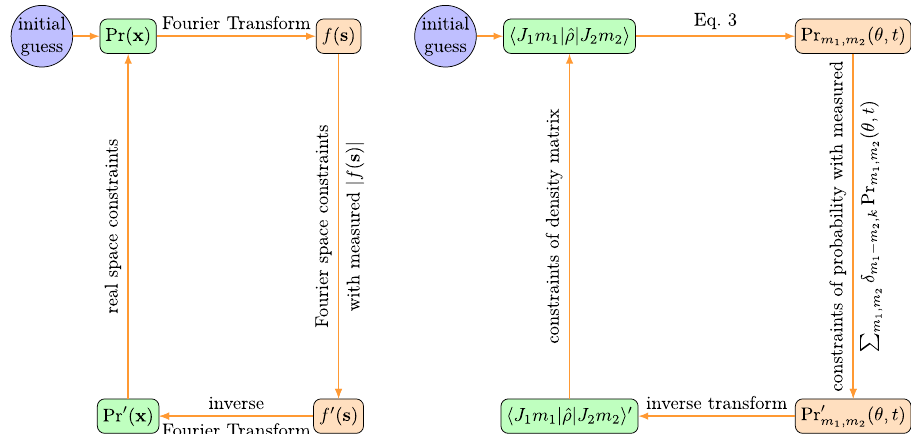
Fig. 2 Analogy between crystallographic phase retrieval (CPR) and quantum tomography (QT) based on their common nature 35 . The CPR iteratively transforms between real space electron density Pr( x ) and Fourier space form factor f ( s ) and impose constraints for both spaces, where Fourier space constraints comes from the measured diffraction intensity that provides the modulus of form factor ∣ f ( s ) ∣ . Analogously, QT iteratively transforms between ð θ ; t Þ in real space and elements in density matrix space, and the probability density evolution Pr( θ , ϕ , t ) is used to blockwise probability distribution Pr m 1 ; m 2 ð θ ; t Þ . constraint the sum of blockwise probability distribution Pr m 1 ; m 2